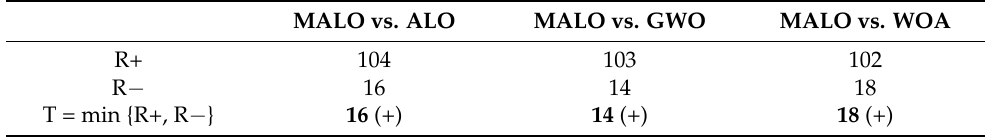
Table 17. The t values of significance test on averaged auc between MALO vs. ALO, MALO vs. GWO, and MALO vs. WOA. MALO vs. ALO MALO vs. GWO MALO vs.